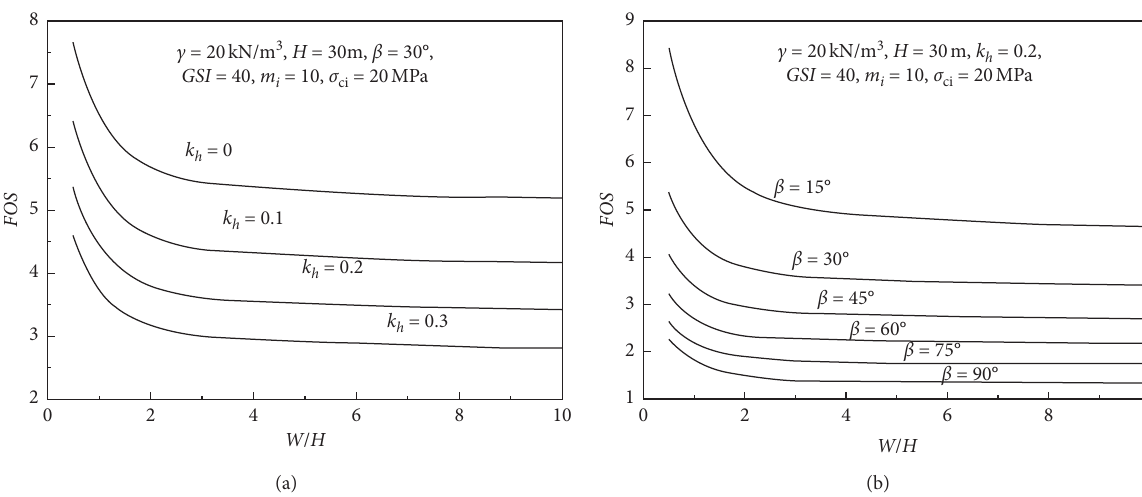
Figure 13: Effects of seismic coefficient k h and slope angle β on 3D rock slope stability: (a) k h , the seismic coefficient; (b) β , the slope